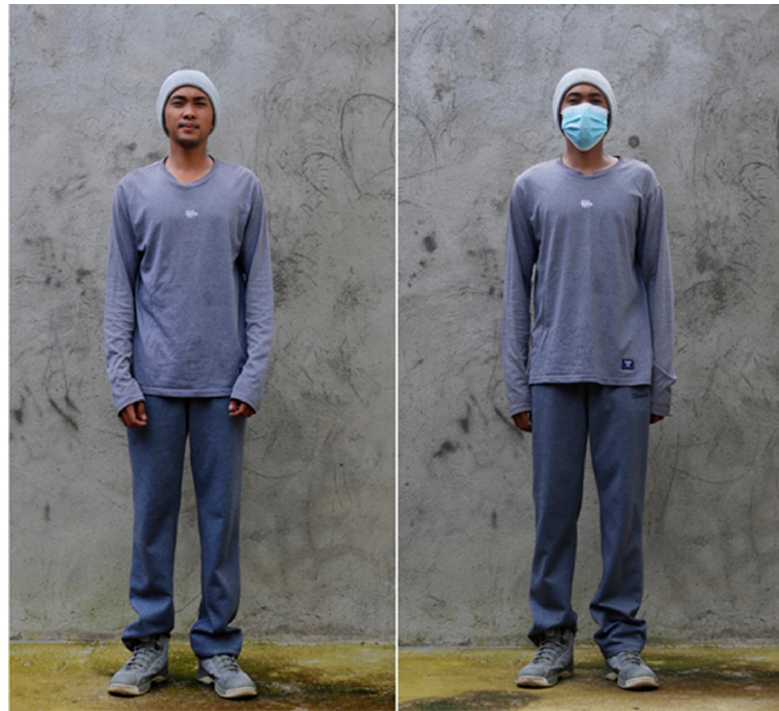
Figure 2. Intrusion treatment ( left : without the mask on, right : with the mask on) and neutral clothing of the intruder. Photographs by: G.N. Fabrero.